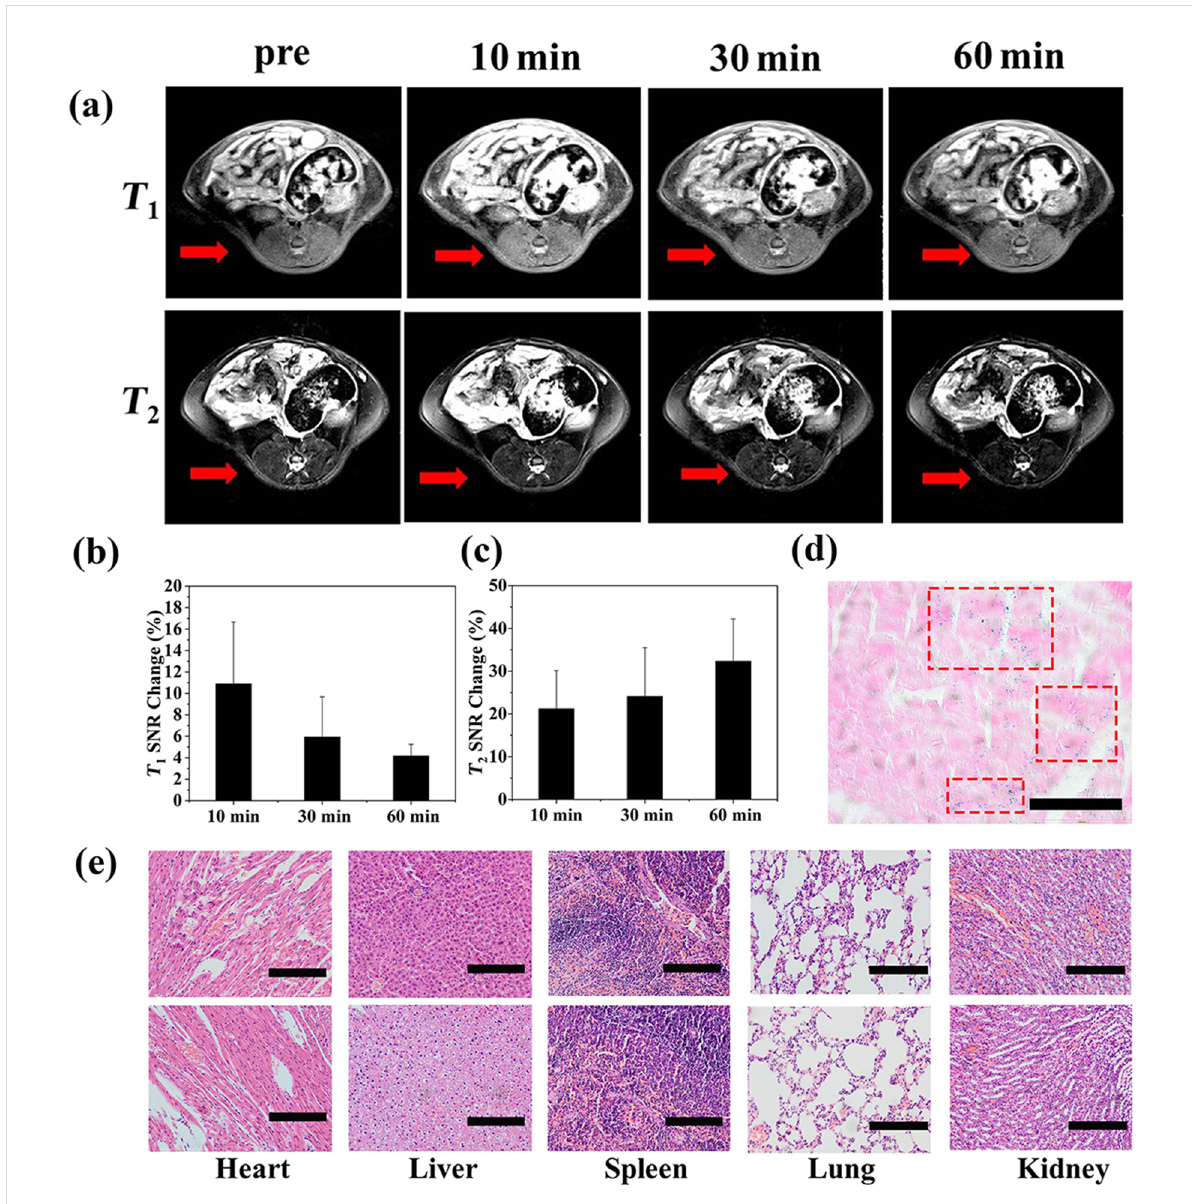
Figure 5: (a) T 1 WI and T 2 WI in vivo images of SD rats before and after intravenous injection of FGDA nanocubes. (b) T 1 and (c) T 2 SNR change post-intravenous injection of FGDA nanocubes. (d) Prussian blue staining in the lumbar muscle of a rat that received an intravenous injection of FGDA nanocubes. Scale bar: 100 μ m. (e) H&E staining of heart, liver, spleen, lung and kidney. Top images: control group, bottom images: rats that were sacrificed two weeks after receiving an injection of FGDA nanocubes. Scale bar: 200 μ